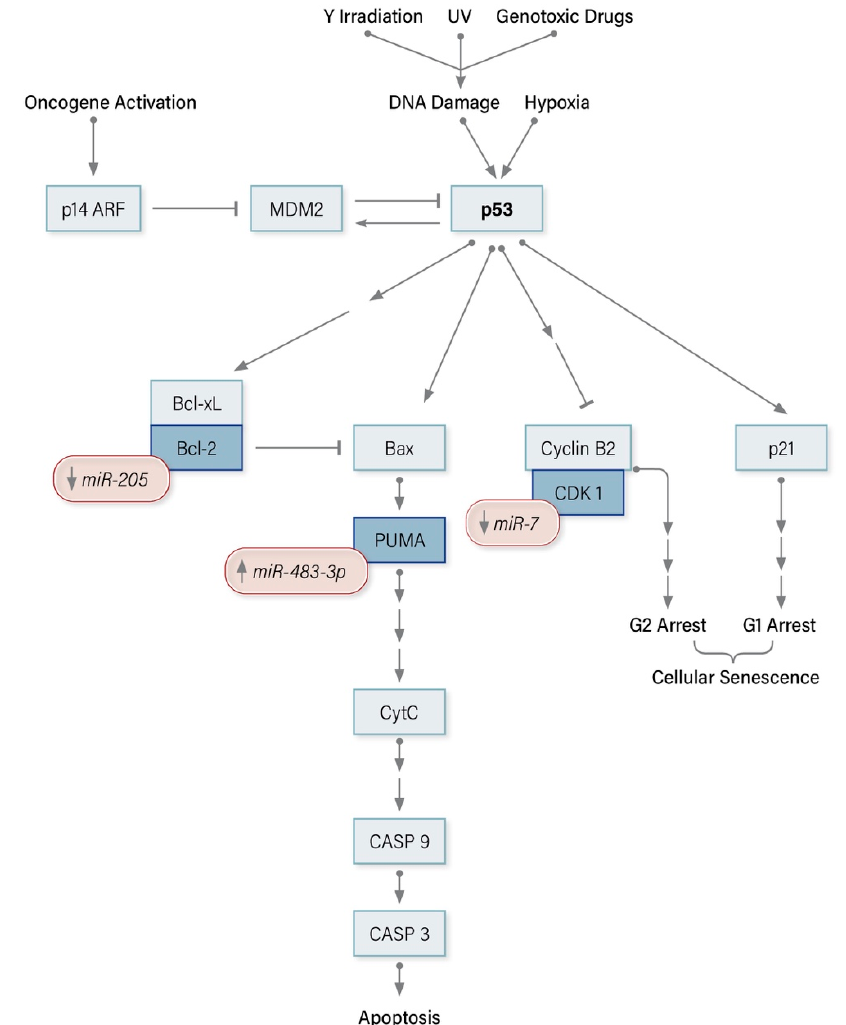
Figure 1. miRNA modulators of the p53 signaling pathway in Adrenocortical Carcinoma.